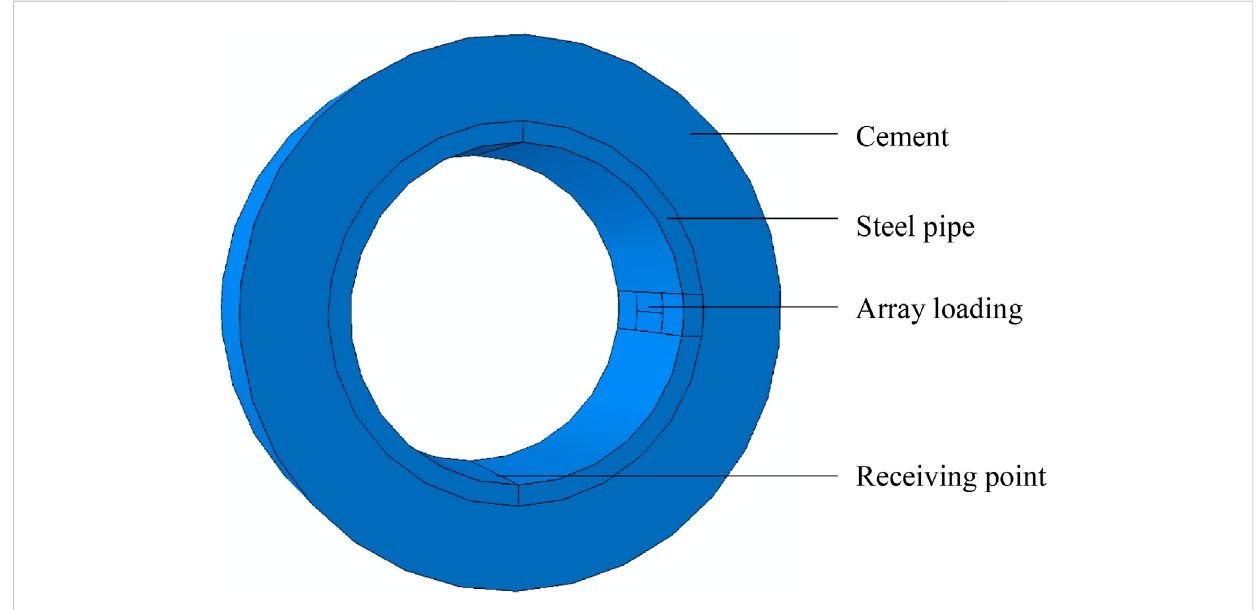
FIGURE 3 3D fi nite element simulation model of cementing casing.